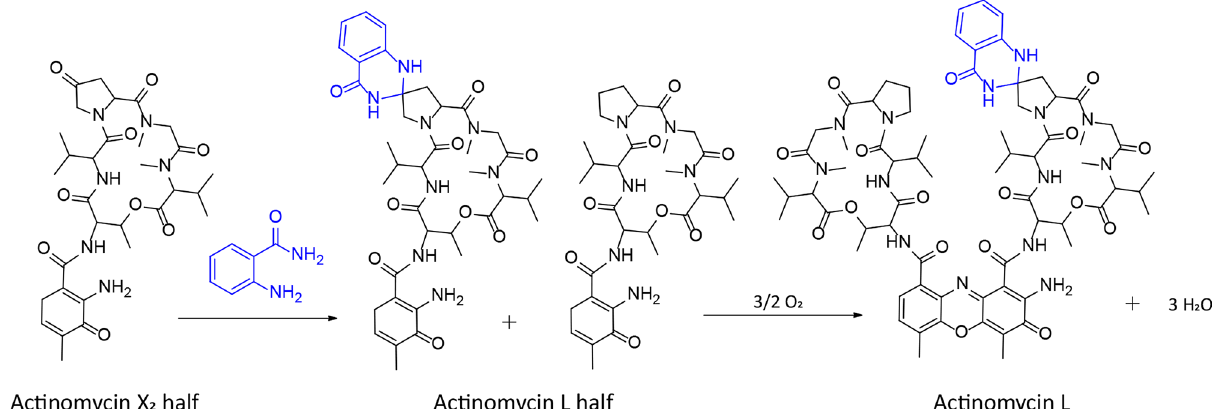
Figure 7. Proposed biosynthetic pathway for actinomycin L. We propose that actinomycin L is formed through the reaction of anthranilamide (blue) with the 4-oxoproline moiety of actinomycin X 2 prior to the condensation of two 4-MHA PPLs into the actinomycin L.